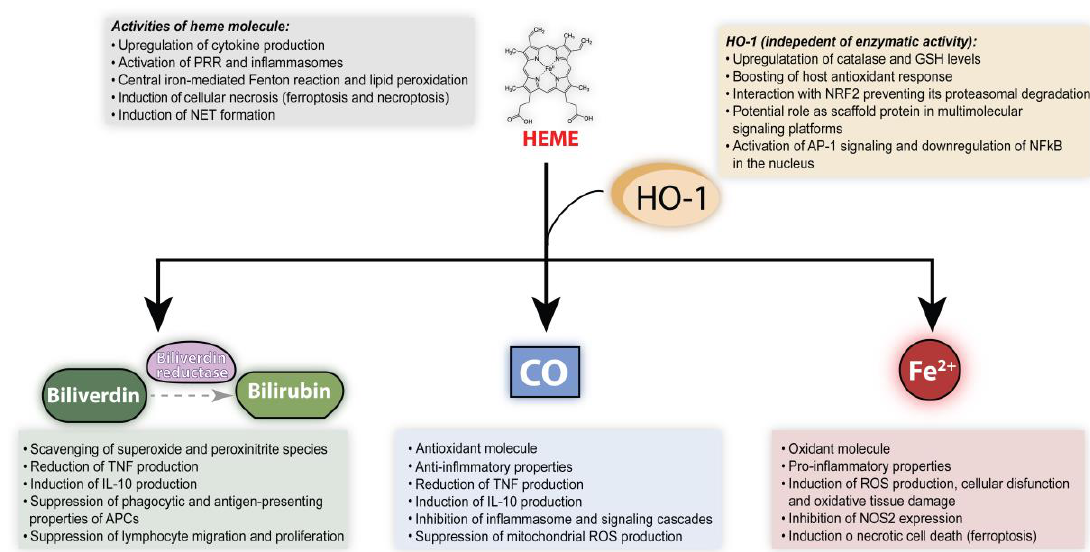
Figure 2. Summary of anti vs pro-oxidant / inflammatory properties of heme, HO-1 and products of heme degradation.